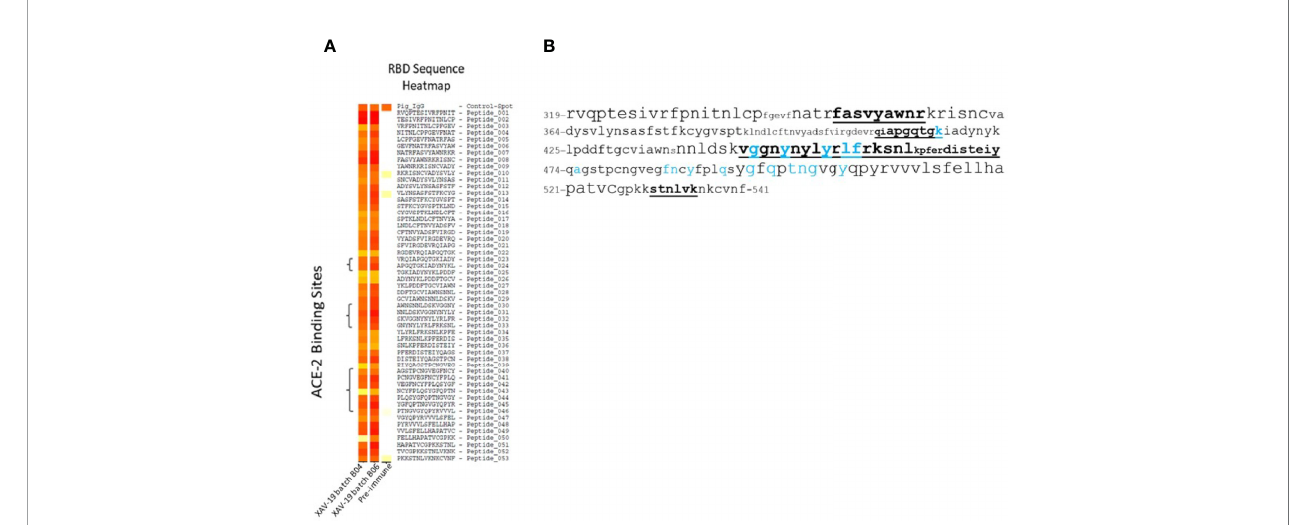
FIGURE 2 | XAV-19 target epitopes. (A) Heatmap from a peptide array experiment showing the binding intensity of two XAV-19 batches and pre-immune IgG to 15-meric peptides of the RBD sequence, overlapping by 10 amino acids. White, no binding; yellow, background binding; light red, medium binding; dark red, strong binding. Positive control: pig IgG spotted on the slides (Control-Spot). Negative controls, human and mouse IgG spotted on the slides, were negative (not shown). (B) XAV-19 target epitopes on the RBD domain (amino acid sequence numbered according to DBSOURCE sequence reference NC_045512.2) as recorded in LC-MS/MS peptide mapping. Font size refers to binding intensity in the peptide array shown in A: font 10, weak recognition; font 14, medium recognition; font 18, strong recognition. Underlined bold: XAV-19 target peptides as de fi ned in LC-MS/MS. Blue characters: amino acids in contact with ACE-2, according to Jafary et al.